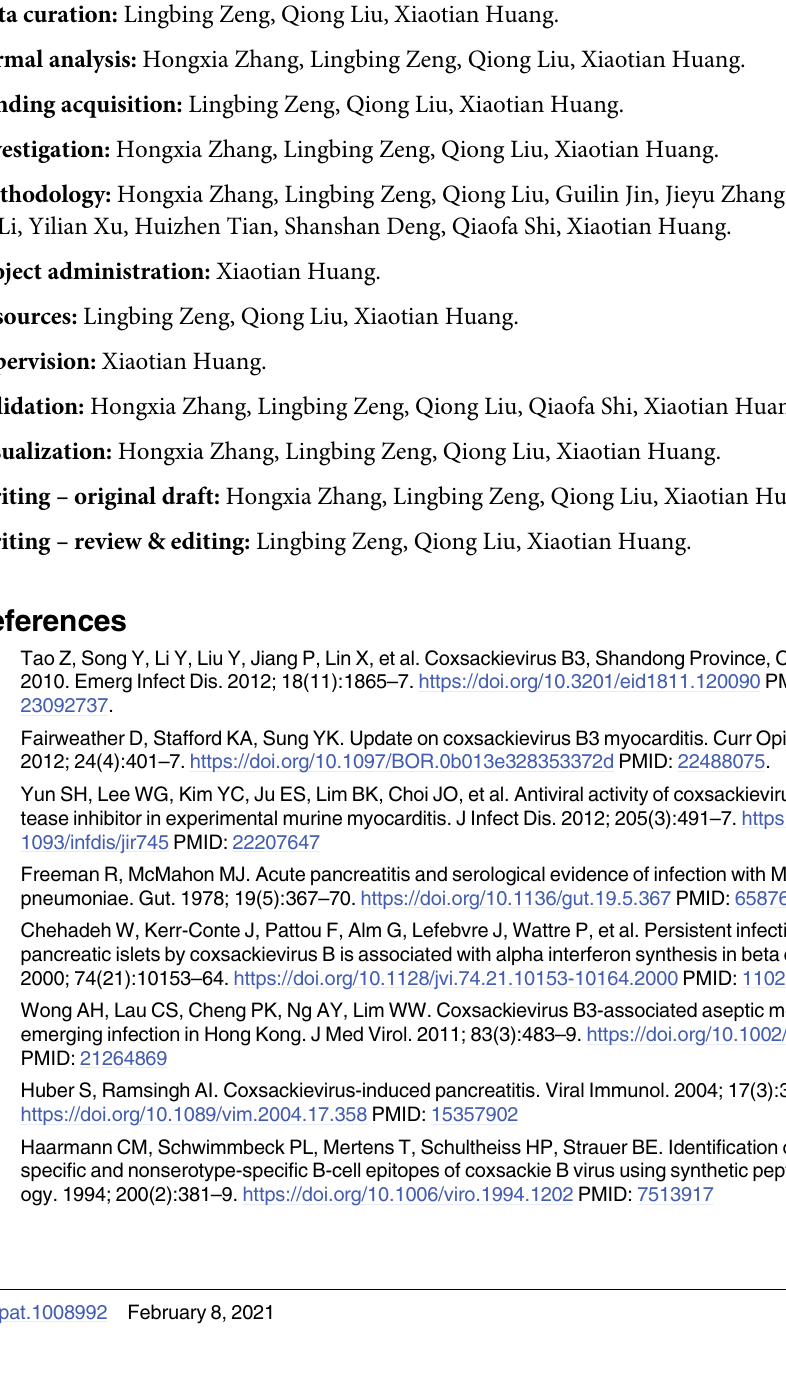
S33 Fig. Immunoblot analysis of the cytoplasmic-localized accumulation of MAT1, CDK7, Cyclin H in CVB3 infected, pBud-VP1 and pBud transfected cells by specific antibodies. This result shows the raw data of the experiment repeated three times by independent researchers. Related to S10 Fig. S1 Table. Primers used in plasmid construction in this